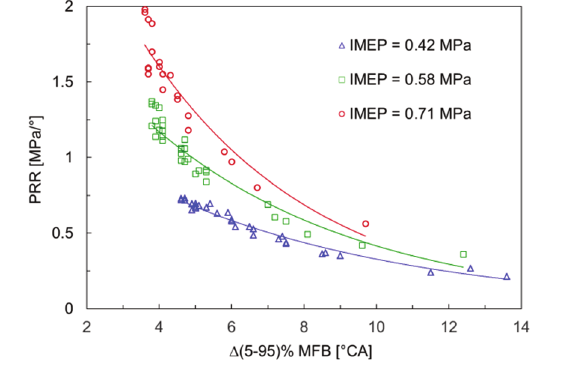
Fig. 3. Heat release rates at IMEP ≈ 0.58 MPa for boost pressure between 0.11 MPa and 0.14 MPa